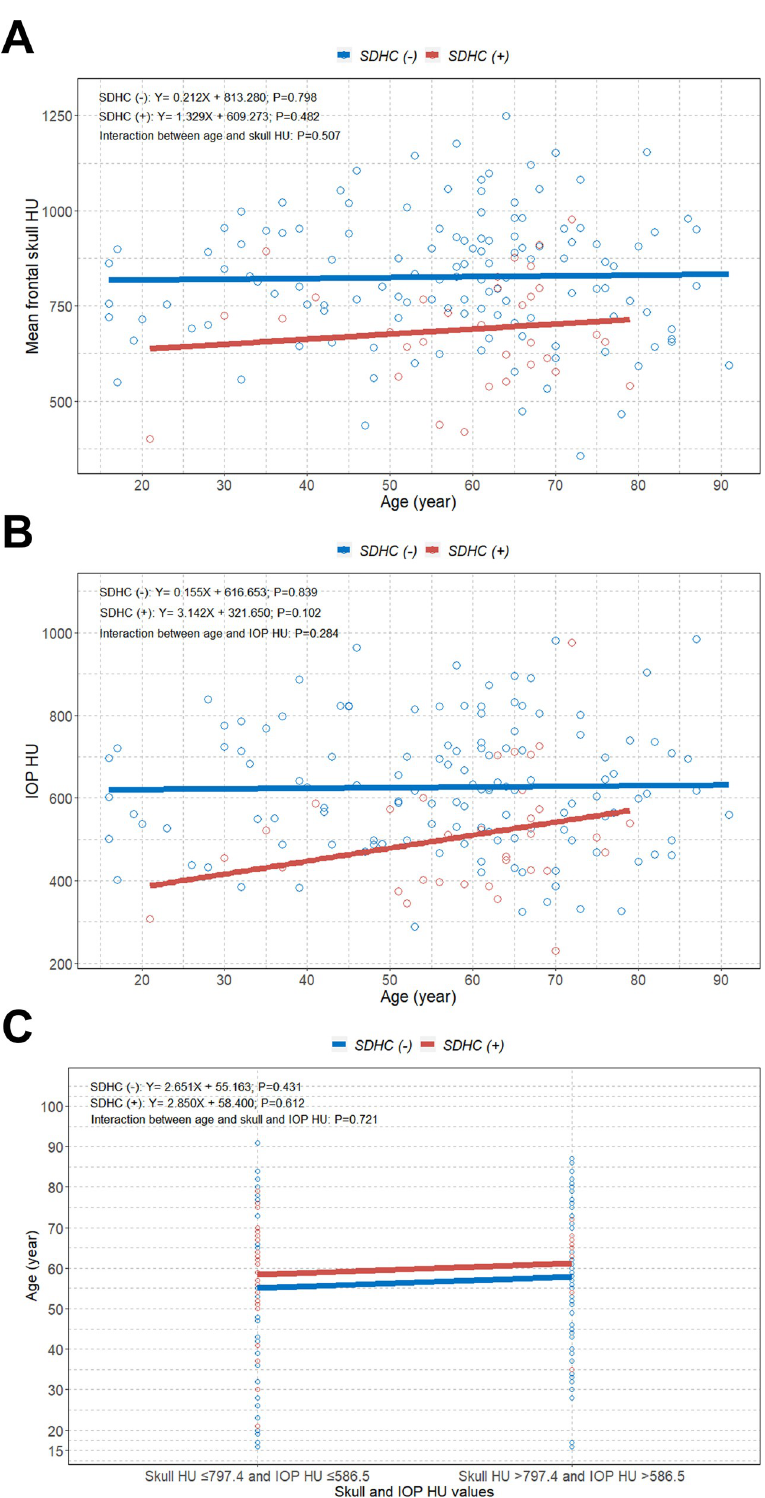
Fig 5. Interaction plots between skull and IOP HU values and age of SDHC. (A) between mean frontal skull HU and age. (B) between IOP HU and age. (C) between simultaneous skull HU and IOP HU binary groups and age. IOP = internal occipital protuberance; HU = Hounsfield unit; SDHC = shunt-dependent hydrocephalus.